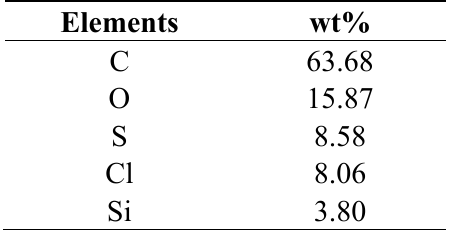
Table 1. Composition of the sensitive film.